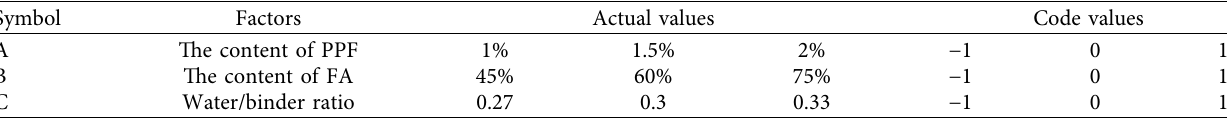
Table 5: Level of experimental factors (given in terms of actual and code values).